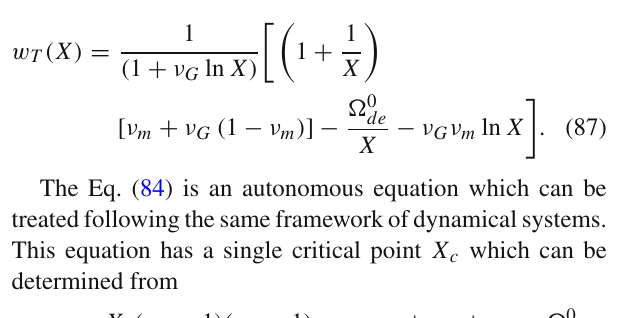
it is depicted the behaviour of the exact relative difference (percentage) defined as (cid:13) r H ( z ) ≡ 100 × | H − H (cid:2) CDM | / H (cid:2) CDM with respect to the concordance model, for ν dm = 0 . 01 and two different values of ν G , the first value ν G = 5 × 10 − 4 (short-dashed line) and the second one ν = 1 × 10 − 3 (large-dashed line). We have used H G s) from Planck 2018